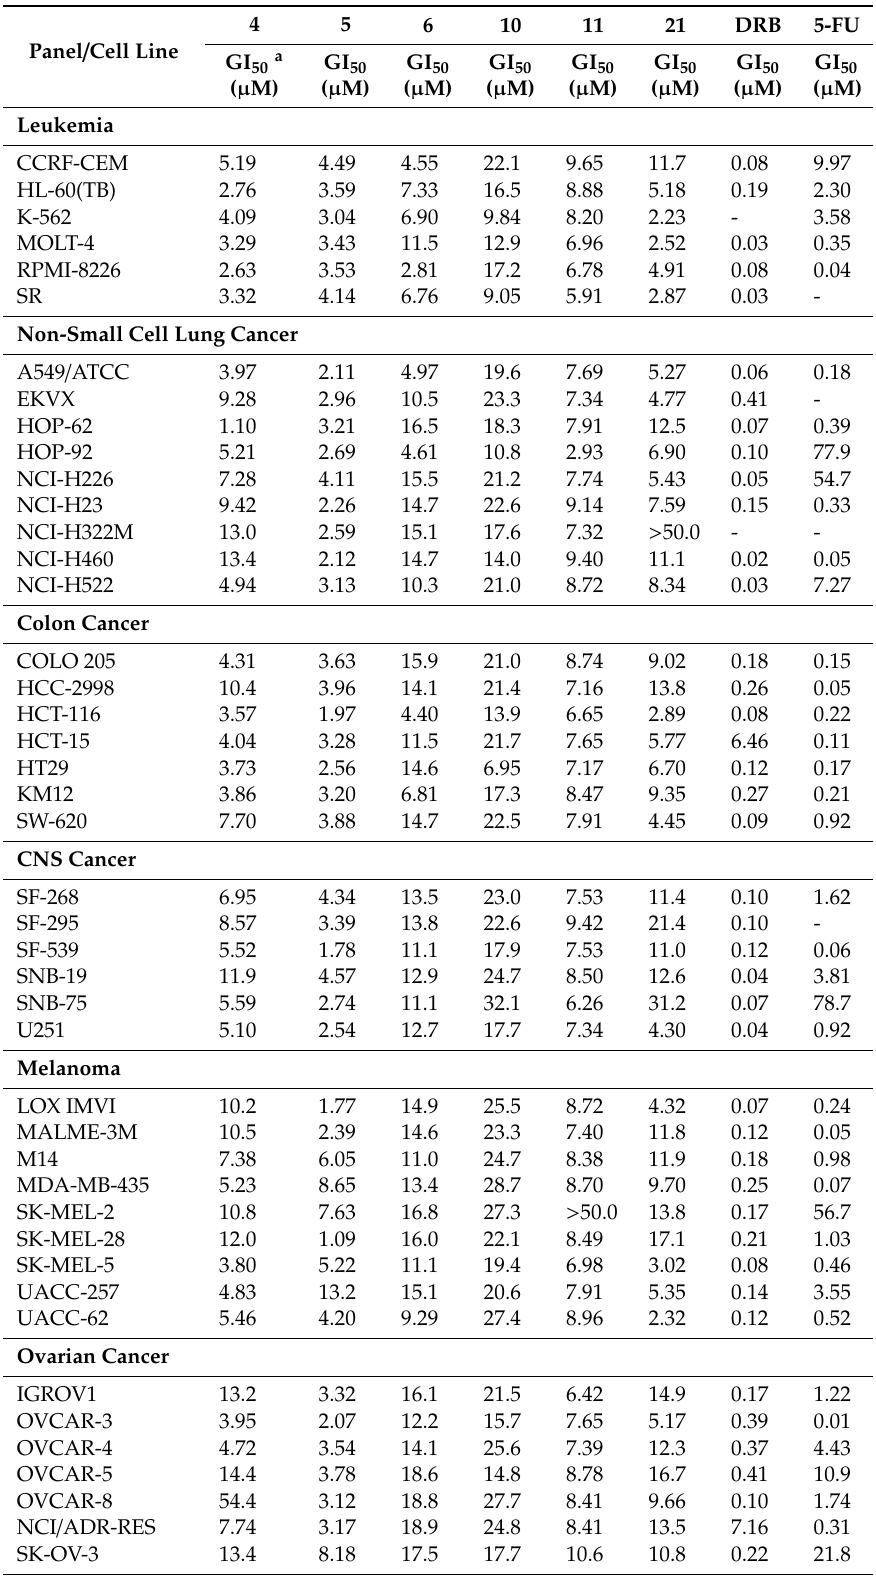
Table 3. In vitro cytotoxic e ff ects of compounds 4–6 , 10 , 11 and 21 and standard drugs doxorubicin (DRB) and 5-fluorouracil (5-FU) against NCI’s human tumor cell line